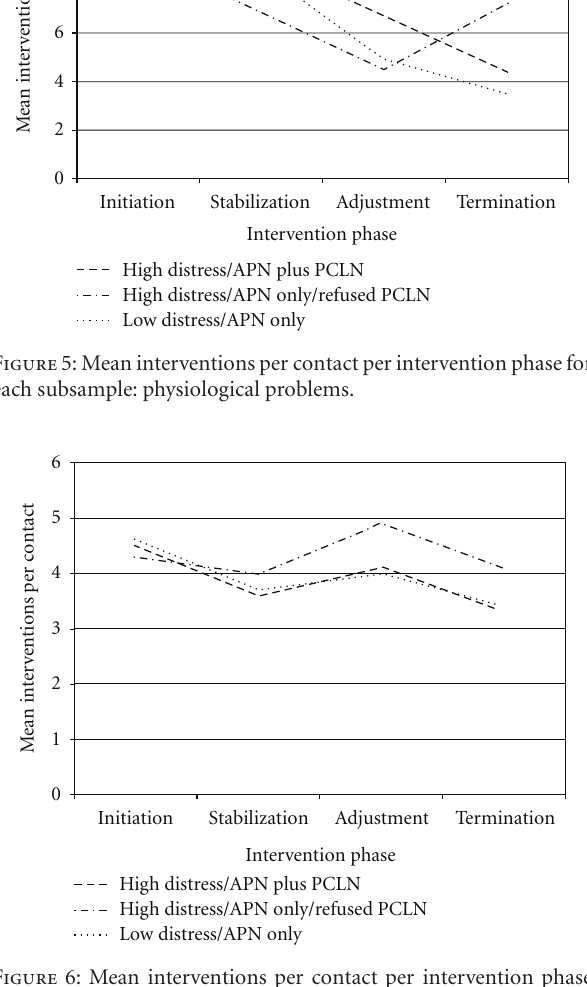
Figure 6: Mean interventions per contact per intervention phase for each subsample: health related behavior